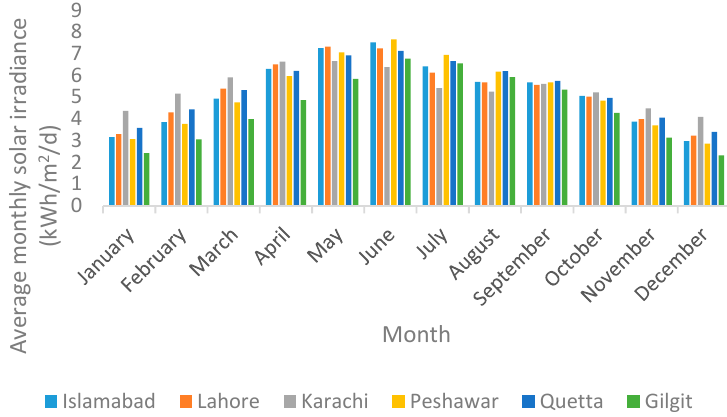
Figure 4. Average monthly solar irradiance data of Islamabad, Lahore, Karachi, Peshawar, Quetta and Gilgit.